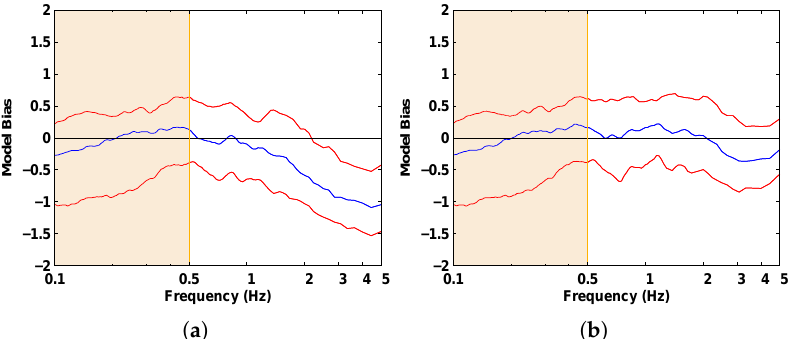
Figure 22. Model bias in the 5%-damped acceleration spectra of the 1999 Hector Mine earthquake synthetics produced using ( a ) the traditional approach of uniformly spaced EGFs and ( b ) using the present approach of unevenly spaced EGFs. Red line: Standard error.